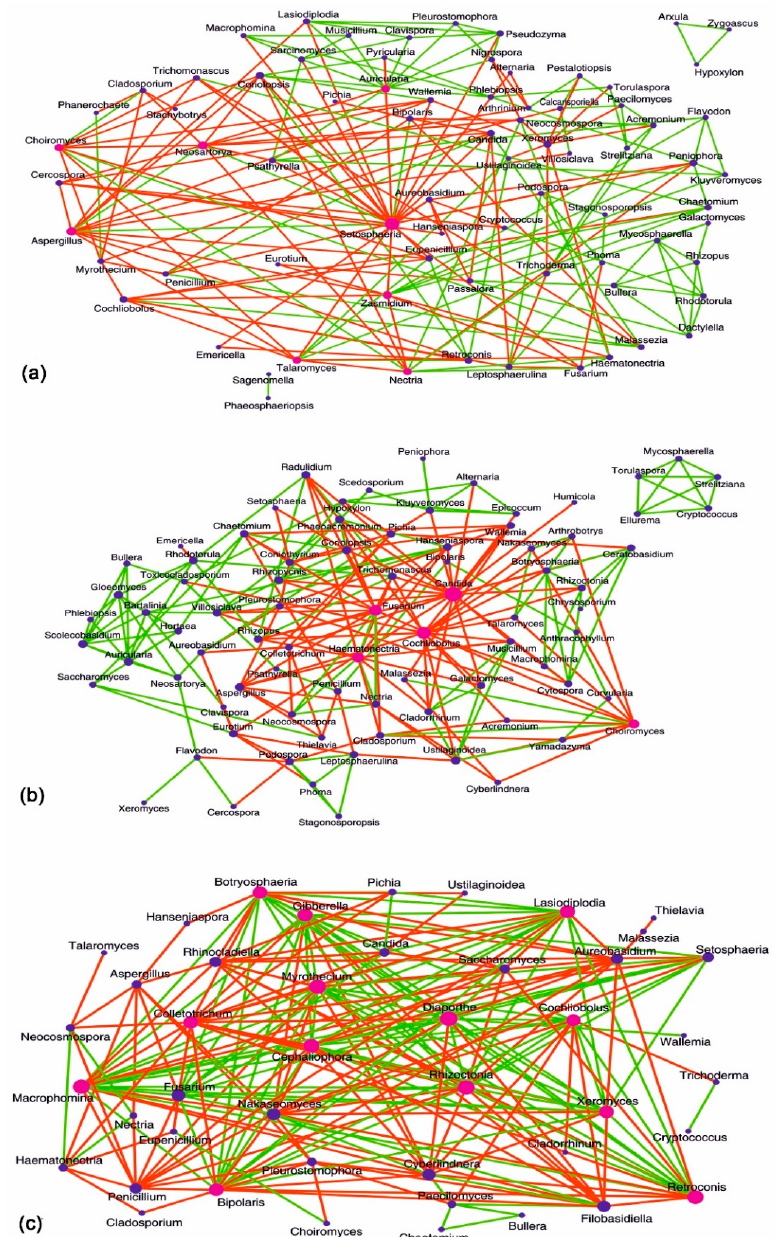
Figure 7. Fungal interaction network in the conjunctival microbiome of healthy (HC-SW) controls ( a ), conjunctival microbiome of fungal keratitis (FK-SW) patients ( b ) and corneal microbiome of fungal keratitis (FK-CR) patients ( c ) showing significant co-occurrence and co-exclusion relationships at the genera level. Each node represents a genus and the sizes of the nodes in the network correspond to their degree of interaction. The hub genera (with > 10 interactions) have been highlighted with pink nodes. The positive and negative correlations / associations have been indicated with green and red edges respectively.